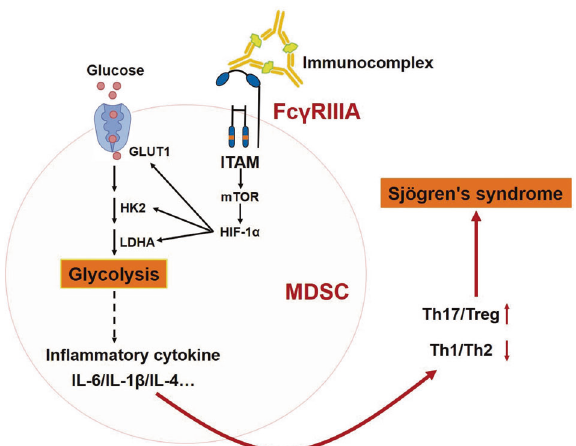
Fig. 8 Schematic representation of Fc γ RIIIA activationinducing MDSCs to alter CD4 + T cell subsets by enhancing glycolysis in Sjögren syndrome. By cross-linking with Fc γ RIIIA on MDSCs, immunocomplex activates the cytoplasmic ITAM, which induces the activation of mTOR to promote the expression of transcriptional factor HIF-1 α . Furthermore, HIF-1 α promote the expression of glycolysis-associated Glut1, HK2 and LDHA to enhance glycolysis, which results in in fl ammatory cytokines up-regulation leading to the decreased Th1/Th2 ratio and increased Th17/Treg